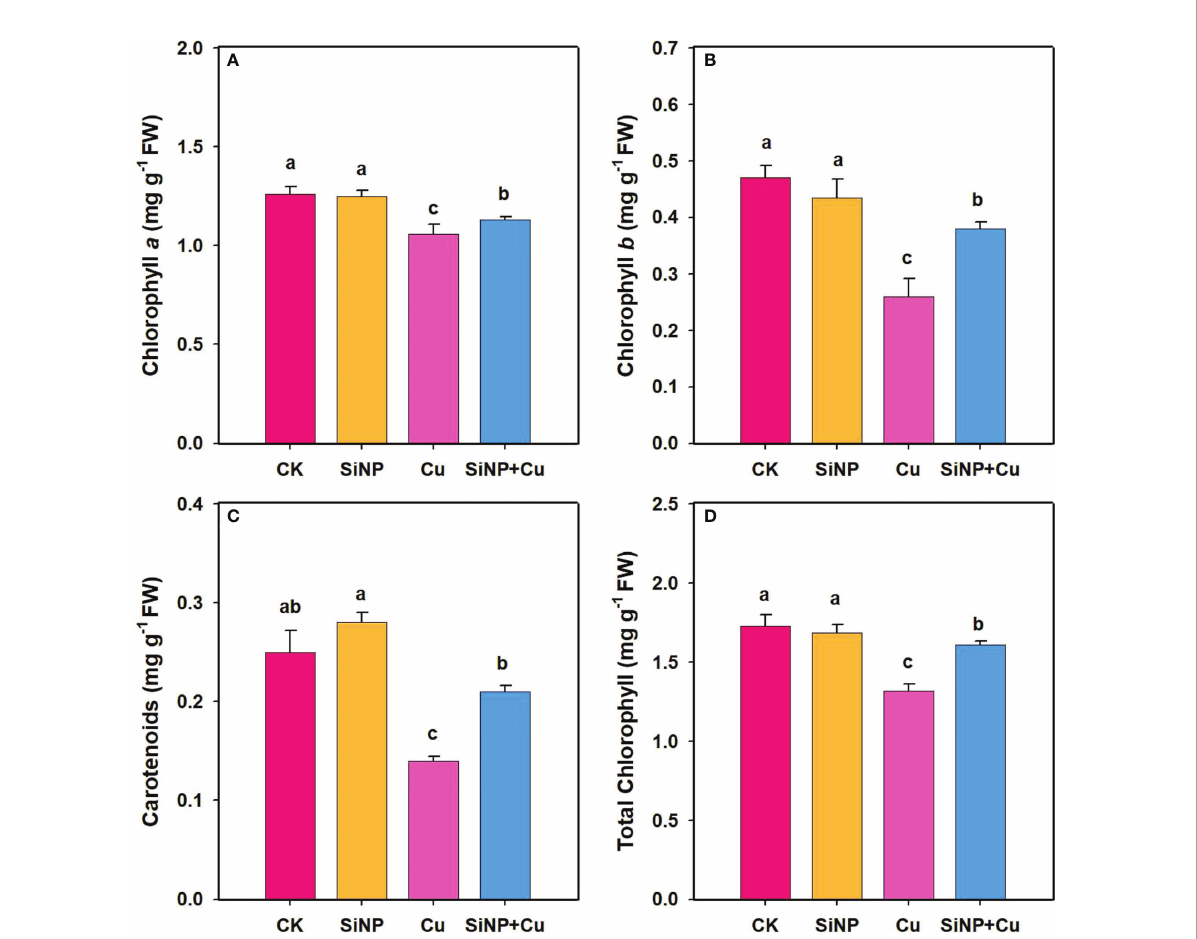
FIGURE 2 Chlorophyll contents of wheat seedlings under Cu 2+ stress. Note “ Experimental treatments contained: CK (control); SiNP (2.5 mM SiNPs); Cu (500 µM Cu 2+ alone), SiNP+Cu (2.5 mM SiNPs+500 µM Cu 2+ ). The different letters (a, b, c, d) describe the differences in different treatments by LSD test at (P ≤ 0.05) ” . (A) chlorophyll a, (B) chlorophyll b, (C) carotenoids, (D) total